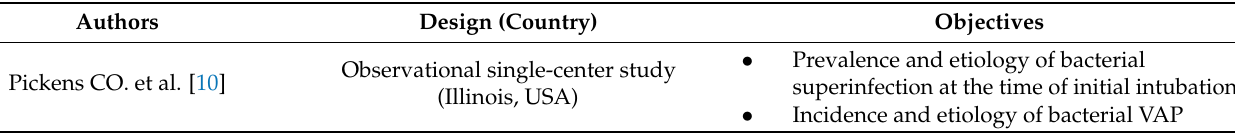
Table 1. Design and objectives of the